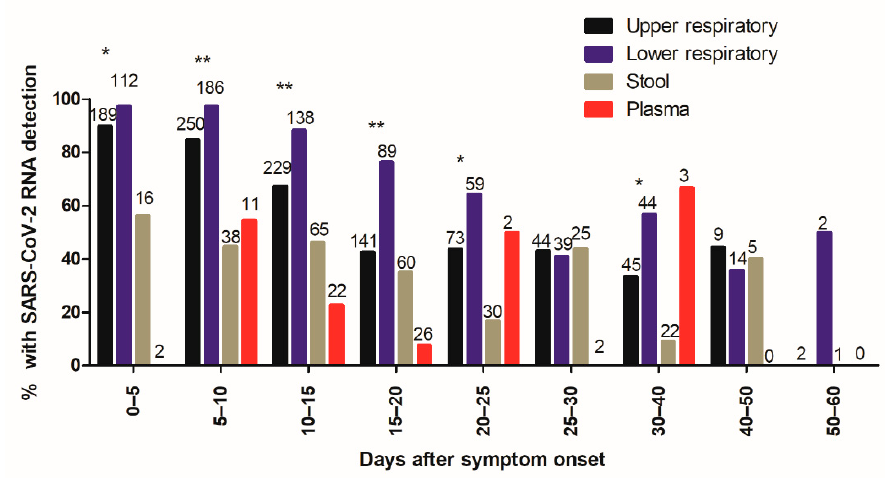
Figure 1. Frequency of SARS-CoV-2 RNA detection as a function of time after symptom onset.